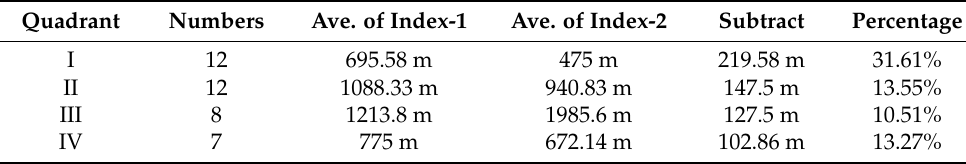
Table 2. Comparison chart of four-quadrants diagram.